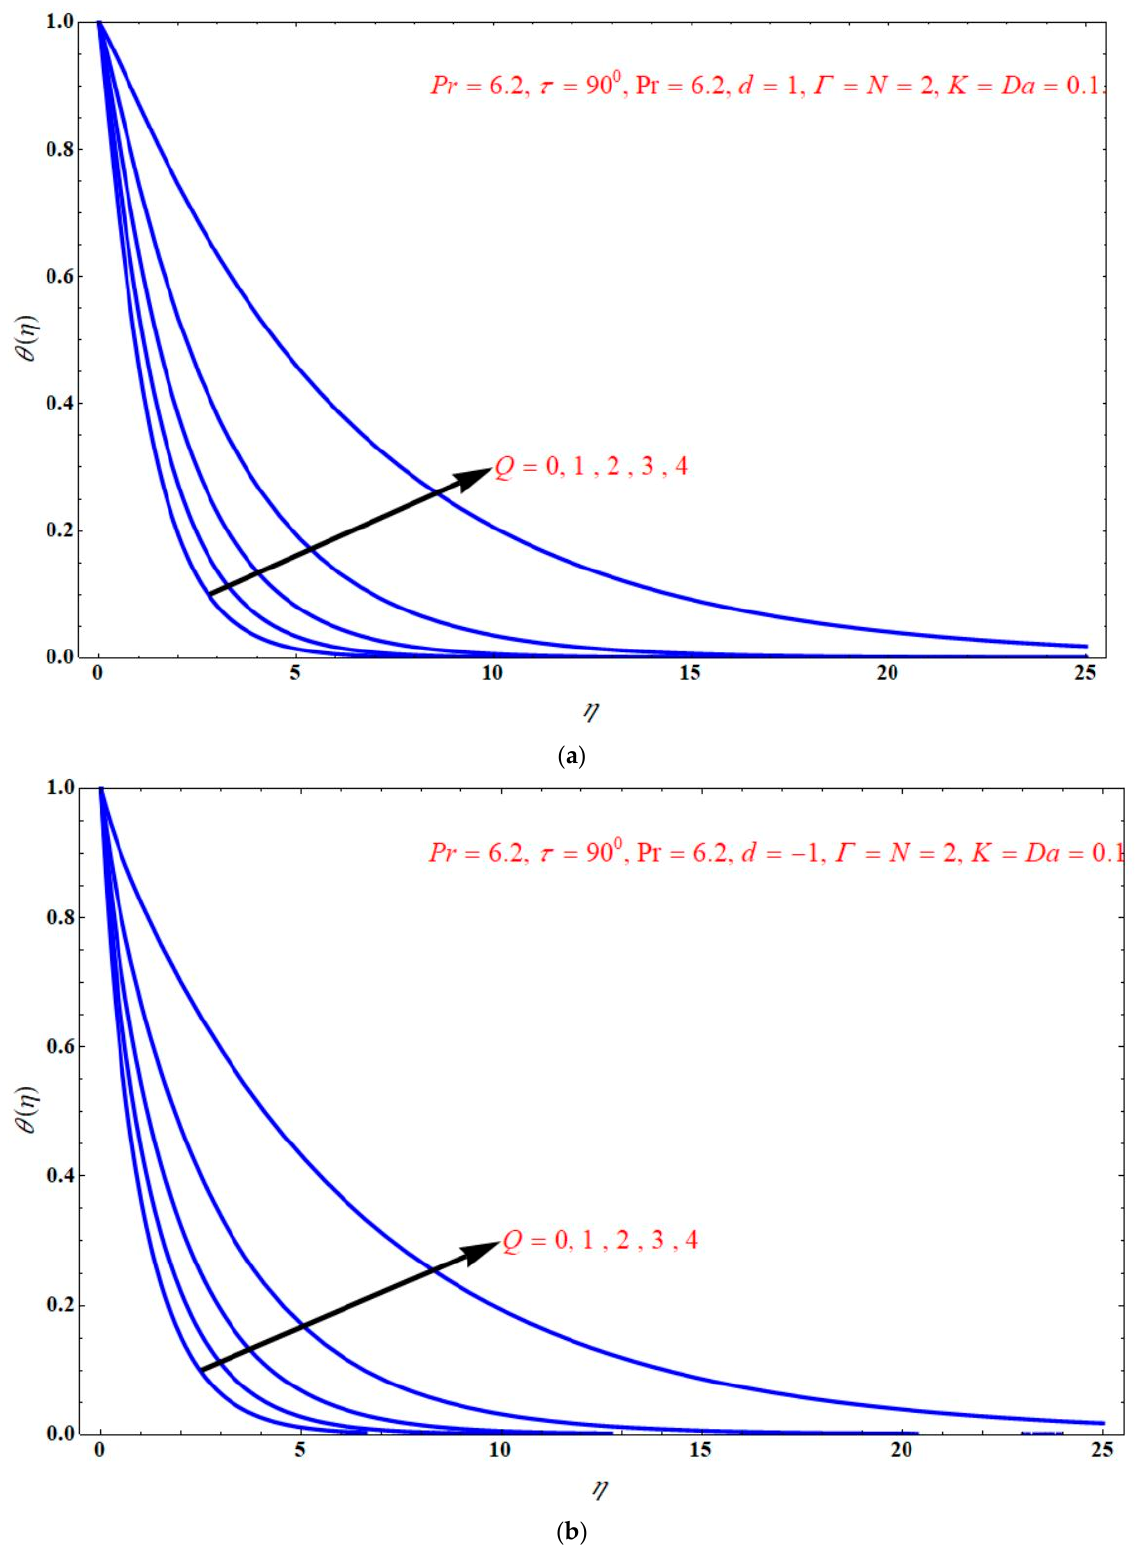
( ) θ η η Figure 6. The plots of verses for different choices of Q for ( a ) 1 d Figure 6. The plots of θ ( η ) verses η for different choices of Q for ( a ) d = 1 and ( b ) d = − 1 d = − .